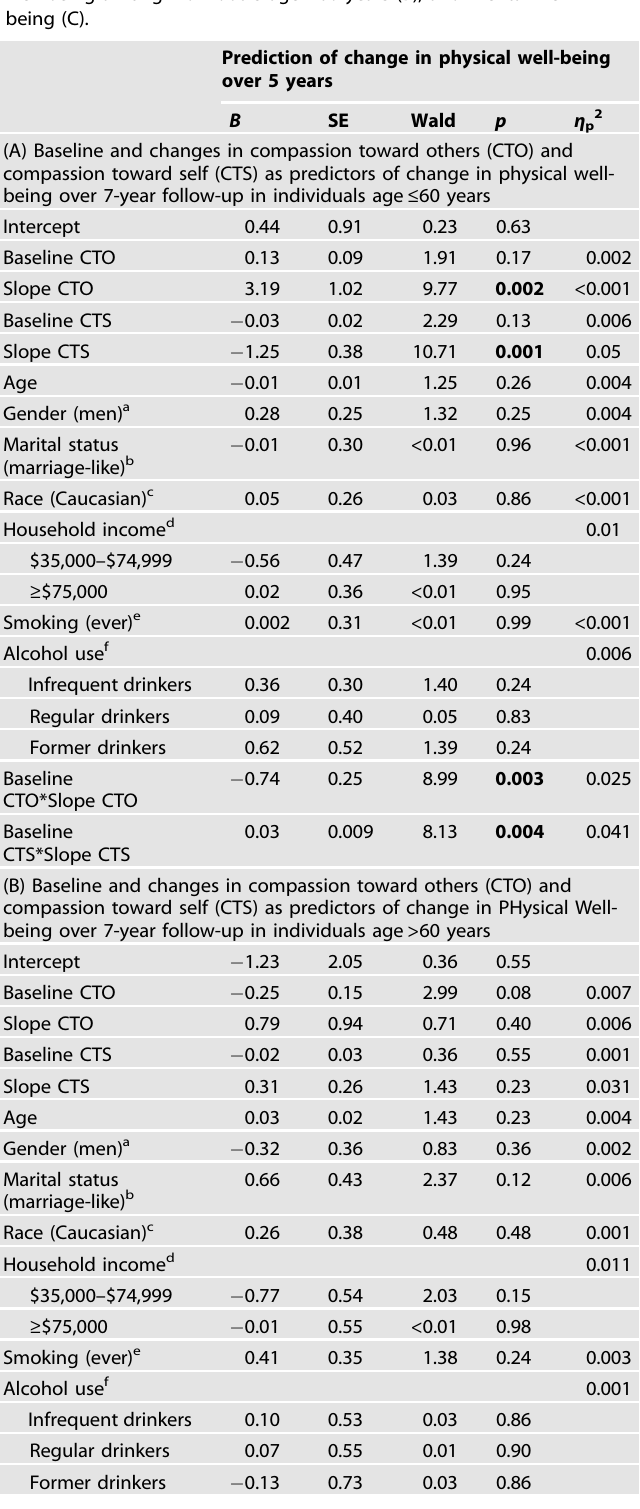
Table 2. Multiple linear regression models of compassion toward others (CTO) and compassion toward self (CTS) with the outcomes of physical well-being among individuals age ≤ 60 years (A) outcomes of physical well-being among individuals age >60 years (B), and mental well- being (C). Prediction of change in physical well-being over 5 years B SE Wald p η p2